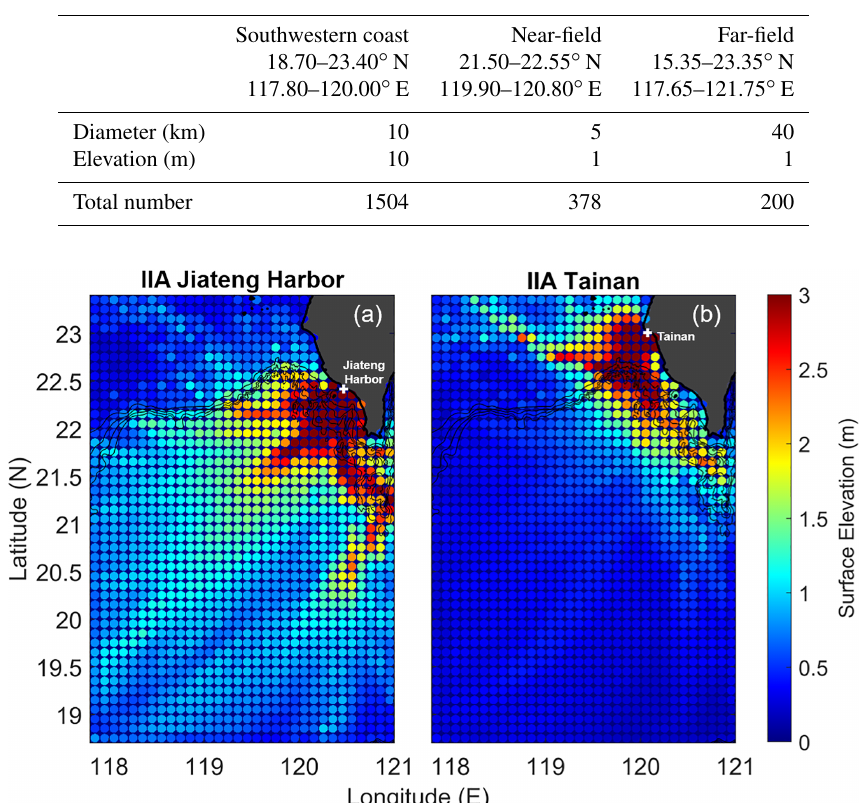
Figure 3. IIA results of the southwestern coast of Taiwan. Panels (a, b) show the IIA result of Jiateng Harbor and Tainan, and the white crosses denote the location of the study sites. The circles represent the locations of unit-source tsunamis, with colors showing the value of maximum wave height recorded at the study